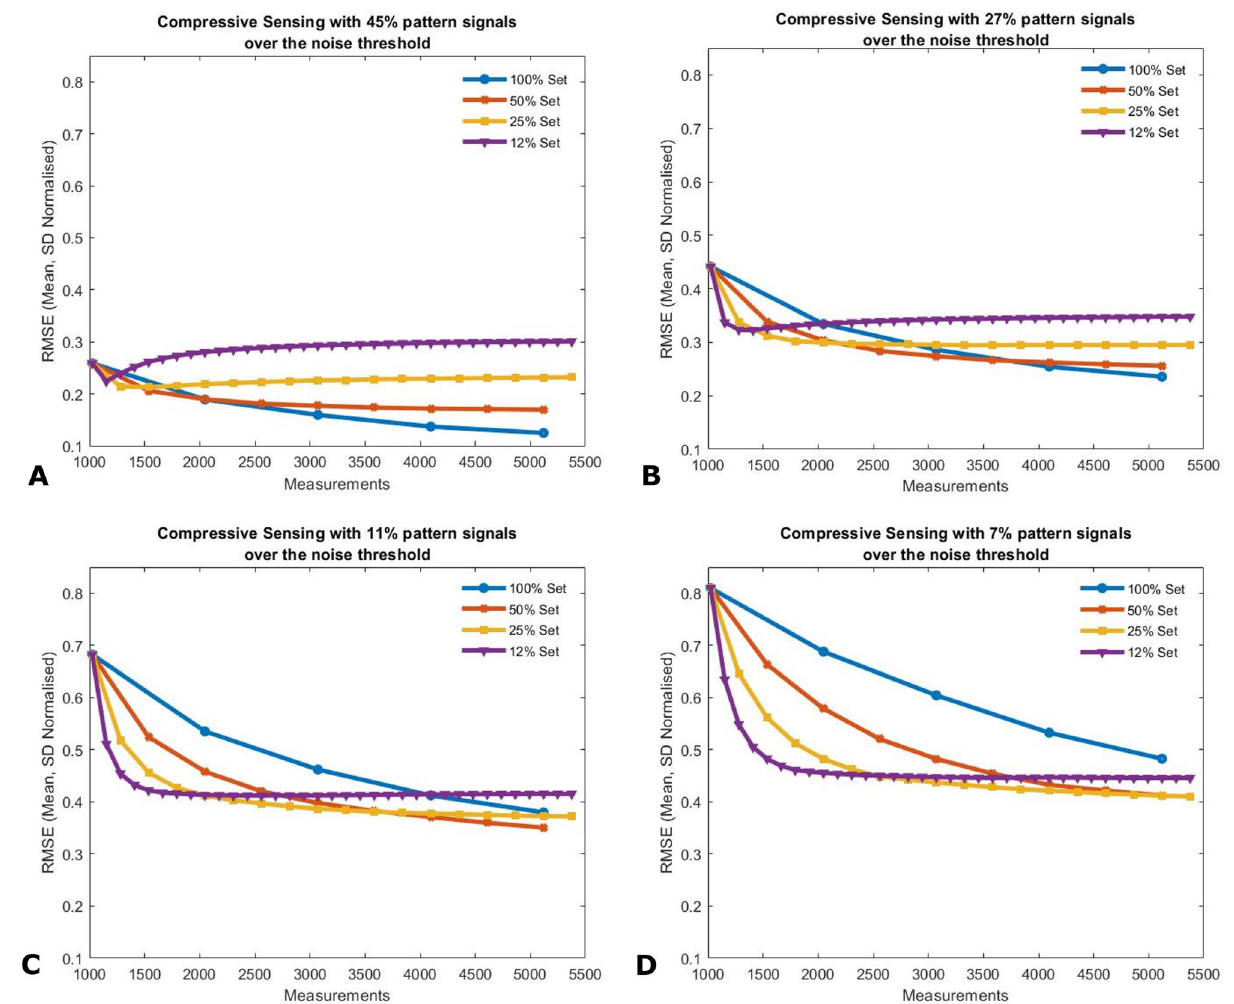
Figure 4. RMS errors of image reconstruction outputs are calculated with respect to the ground truth image as a function of the number of measurements for varying degrees of image compression and SNR regimes. The cases presented here are the ideal condition ( A ) and the three subsequent scenarios ( B – D ) with increasingly poor SNR. In low SNR conditions ( C , D ), compressed sensing shows a better reconstruction up until 3000–4000 patterns. However, the overall image quality does reduce as a function of